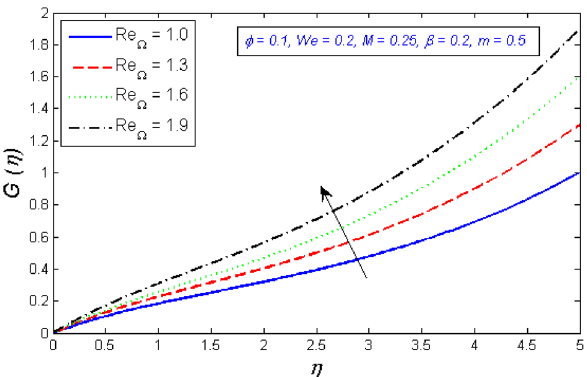
Figure 15. Variation of tangential velocity distribution for several number of Local Reynolds number established on the cone angular velocity Re (cid:31)